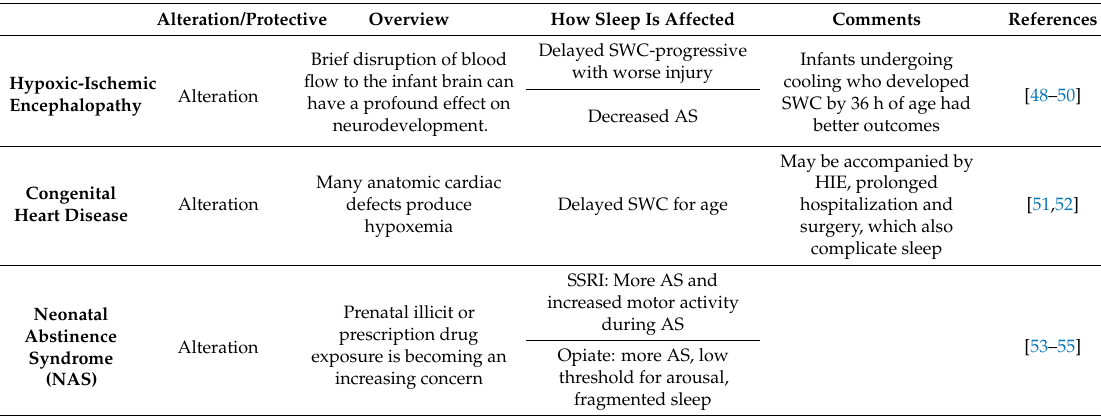
Table 2. Neonatal disorders associated with sleep